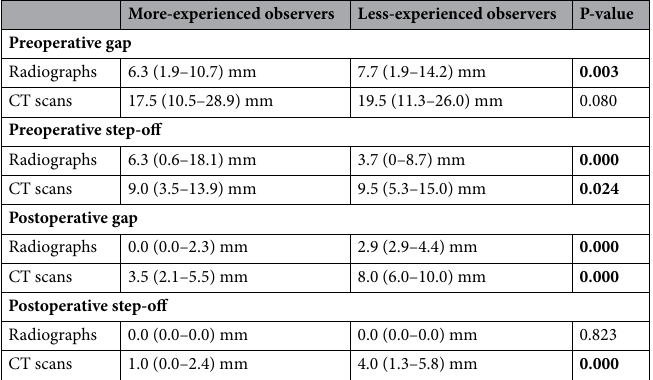
More-experienced observers Less-experienced observers